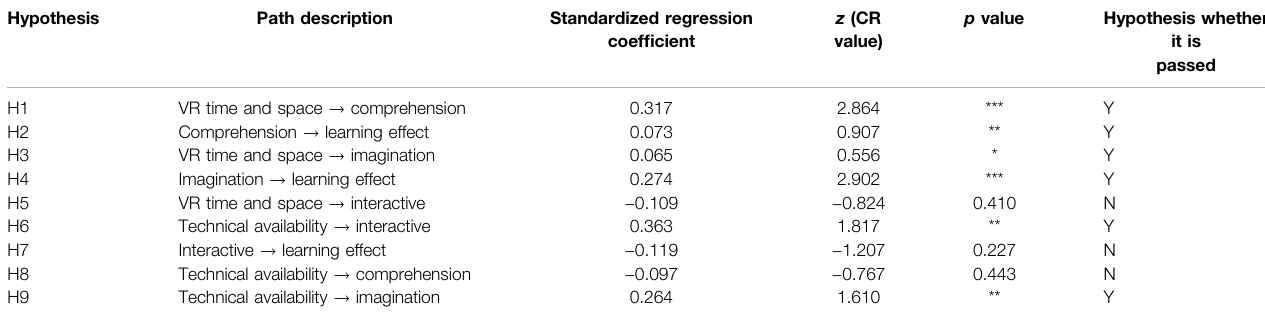
TABLE 7 | Standardized regression coef fi cient and its distinctiveness.